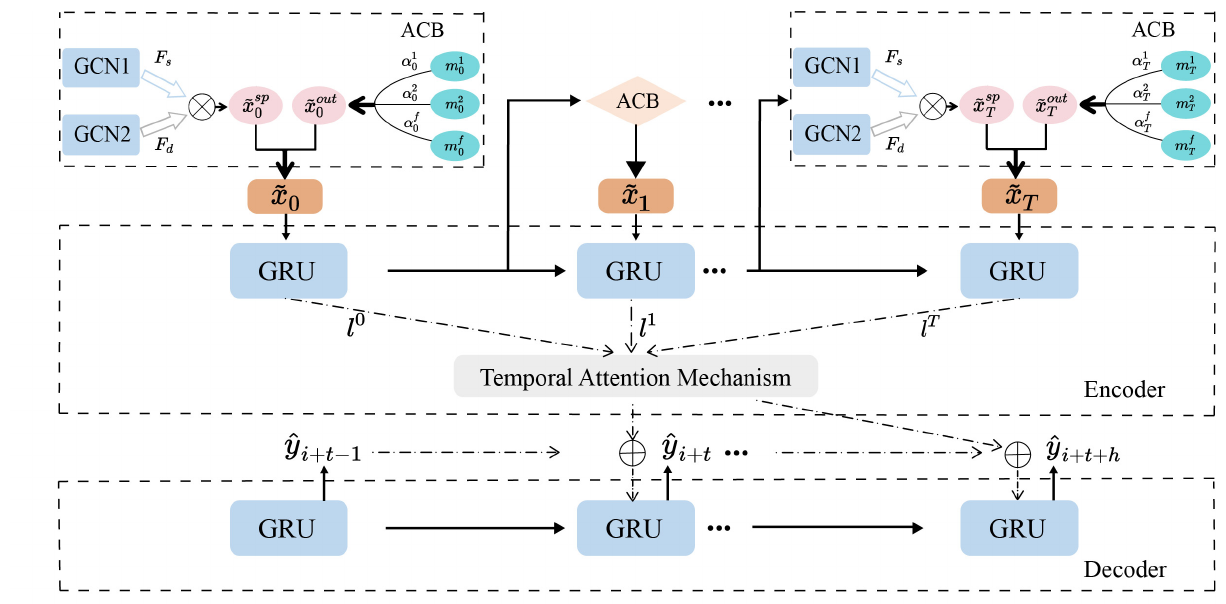
Figure 2. Architecture of the heterogeneous graph convolution